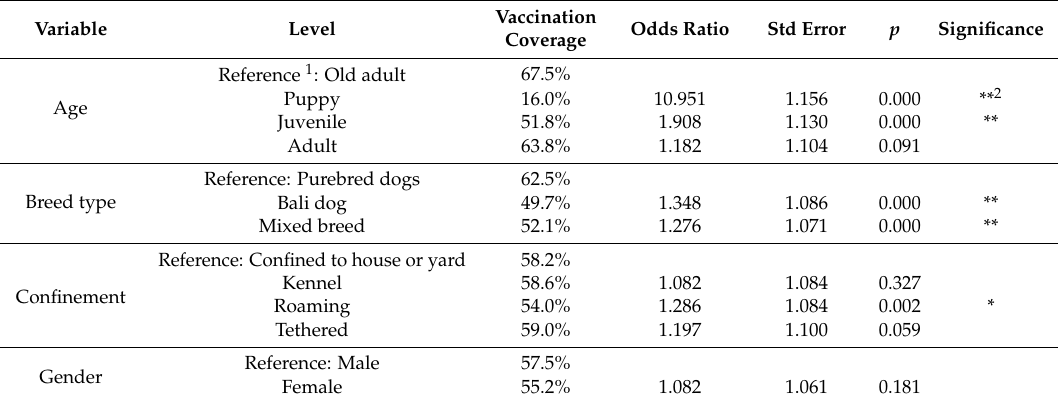
Table 1. Odds ratio of not being vaccinated for each variable in a logistic regression main effects model with one level acting as the reference against which all other levels are compared.